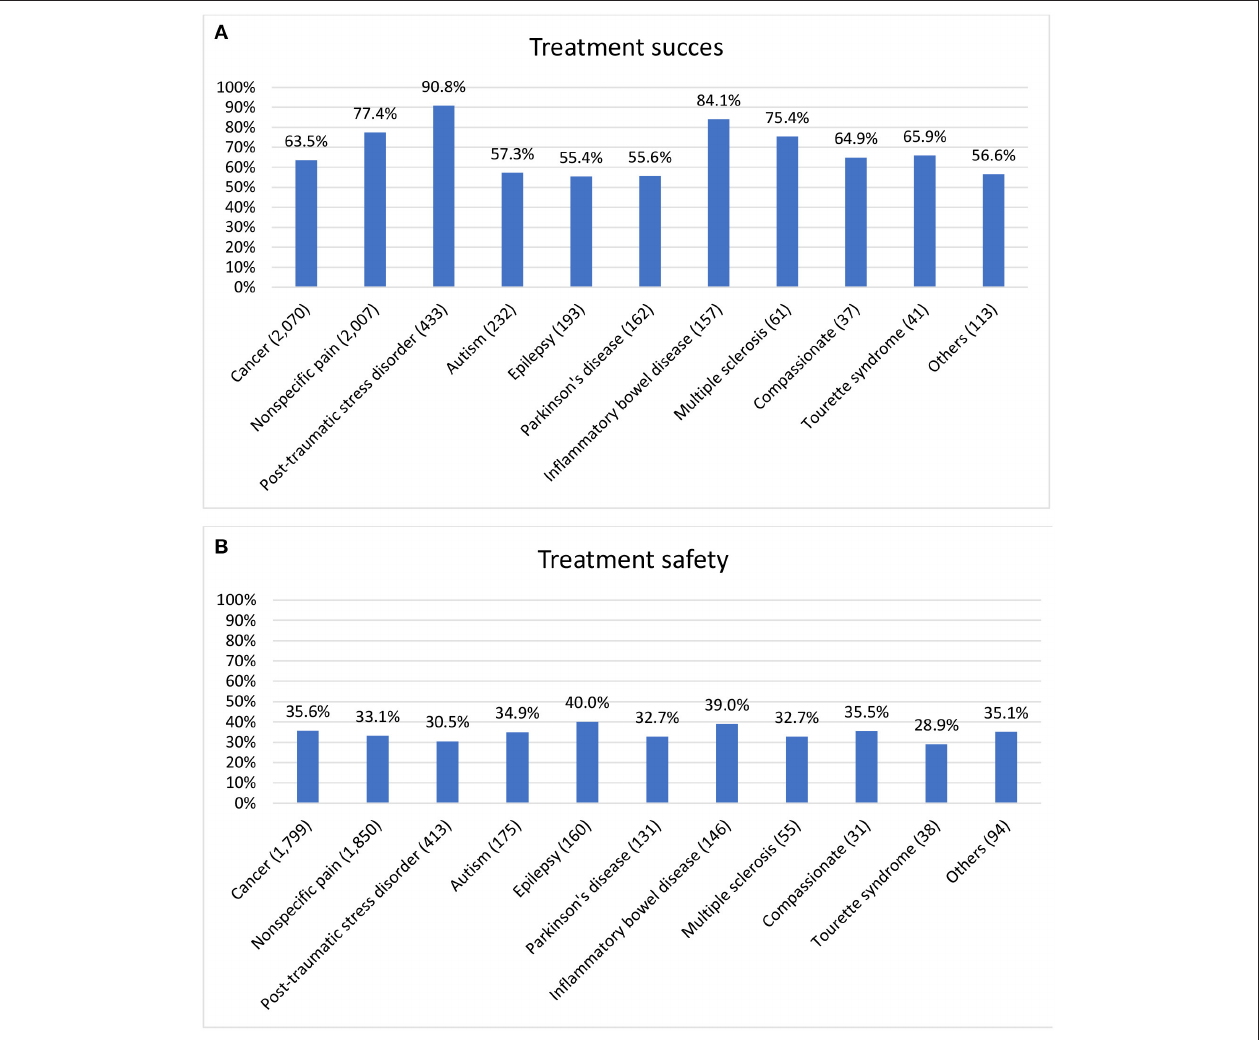
FIGURE 4 | Safety and effectiveness rates by indications. (A) Treatment success in 4,345 patients who responded to the 6-month follow-up questionnaire (and to the general effect question) and in 1,160 patients who discontinued treatment, by the primary indication for the cannabis treatment. Treatment success was defined as at least a moderate or significant improvement in the patient’s condition and none of the following: cessation of treatment or serious side-effects defined as 9–10 out of 10 on the severity scale. (B) Treatment safety—presence of any side-effect in 4,891 active and inactive patients who responded to the side-effect questions at